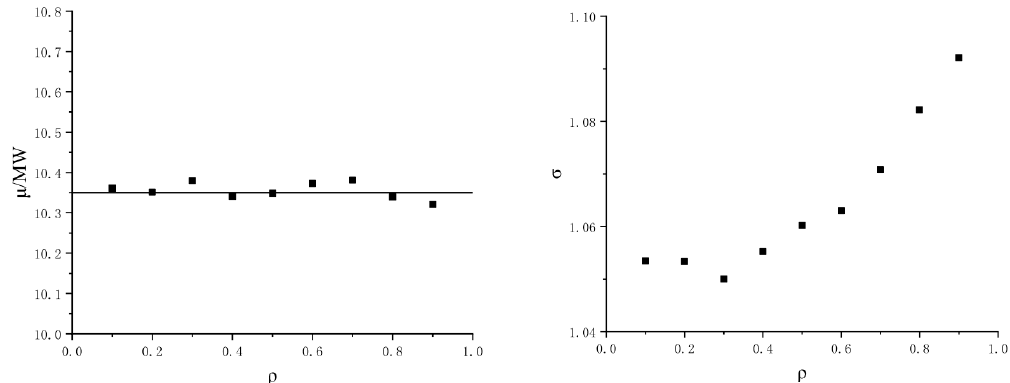
Figure 7. E ff ect of wind speed correlation of node 30 on wind power output. Figure 7. Effect of wind speed correlation of node 30 on wind power output.